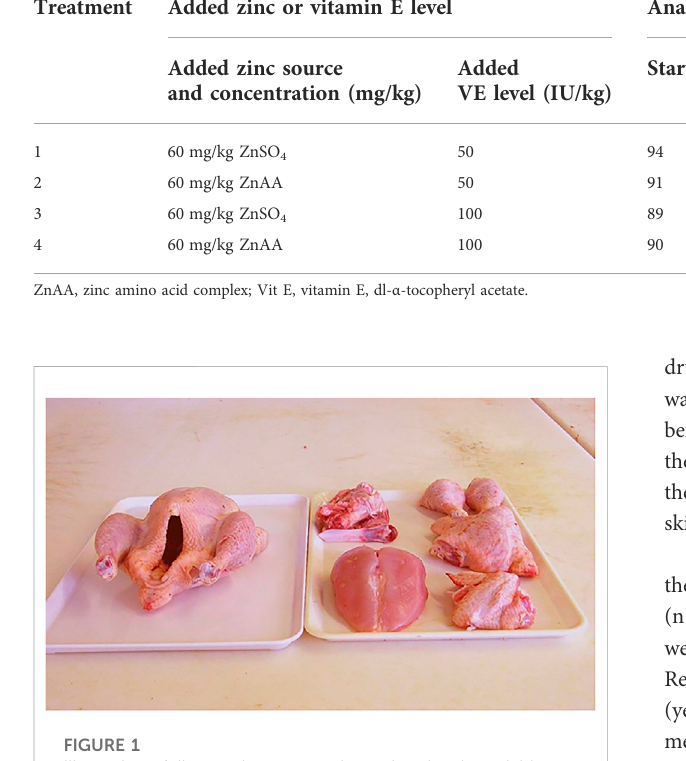
TABLE 2 Analyzed zinc and vitamin E concentrations in the different dietary treatments for broilers. Treatment